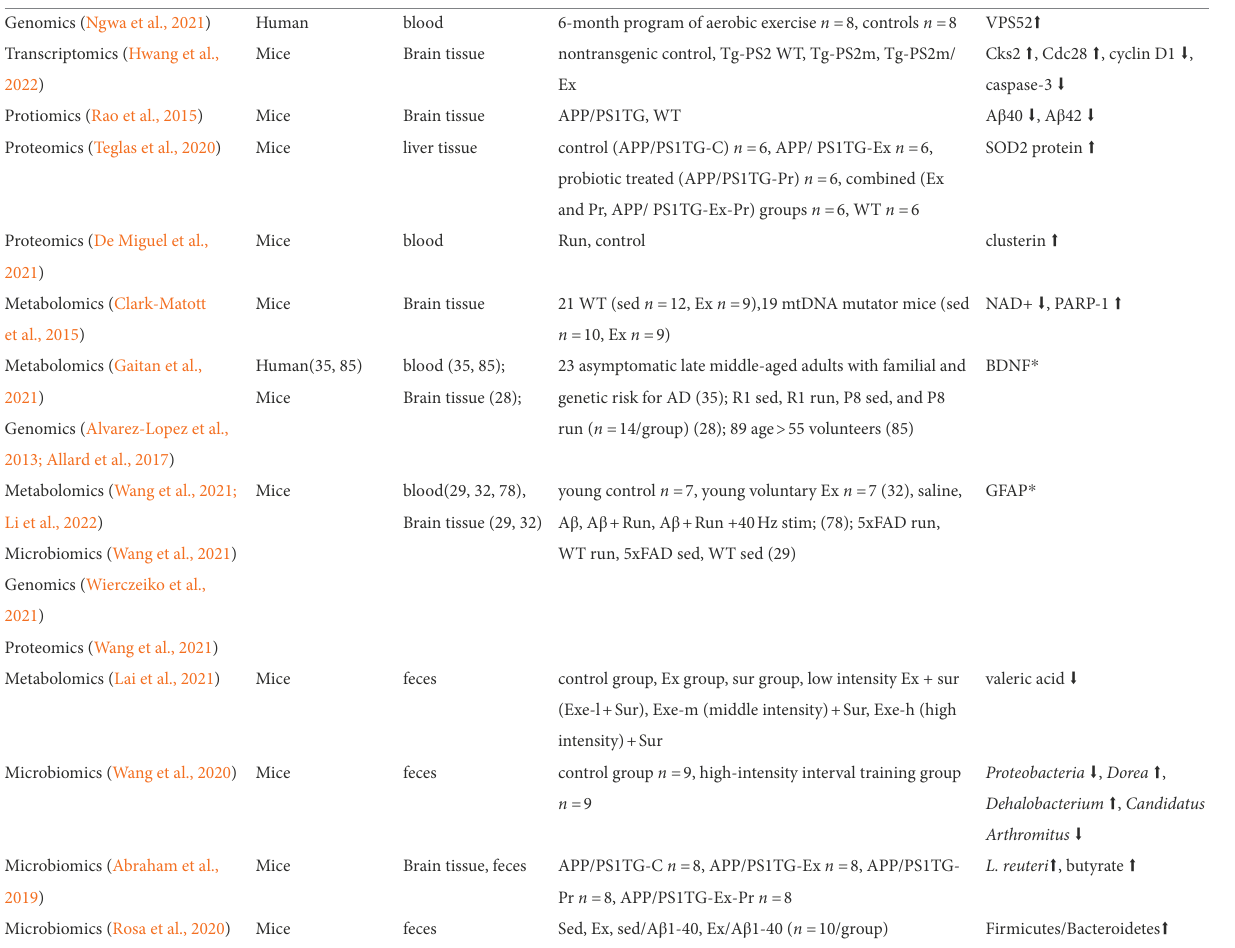
TABLE 1 Multi-omics studies of exercise and